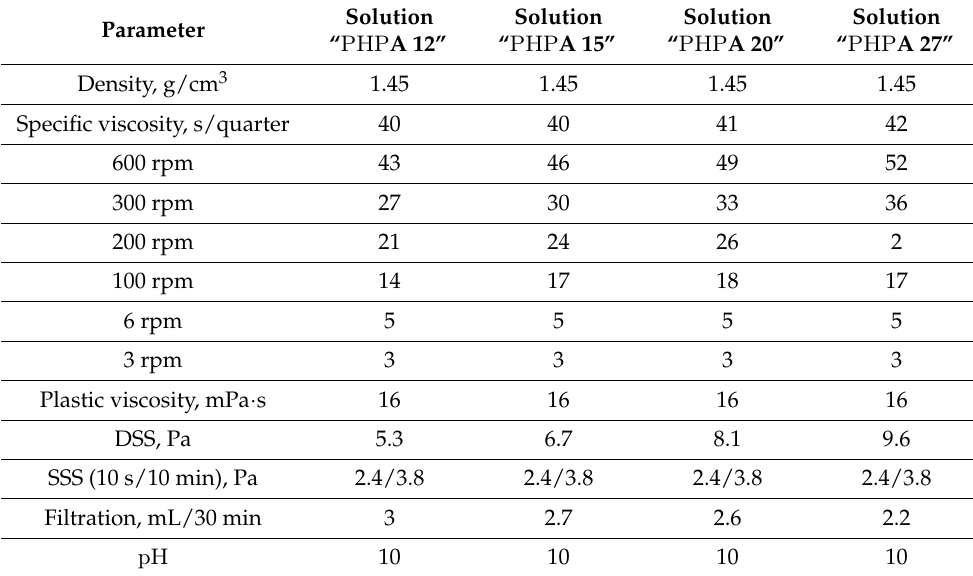
Table 3. Parameters of the formate-based mud formulations